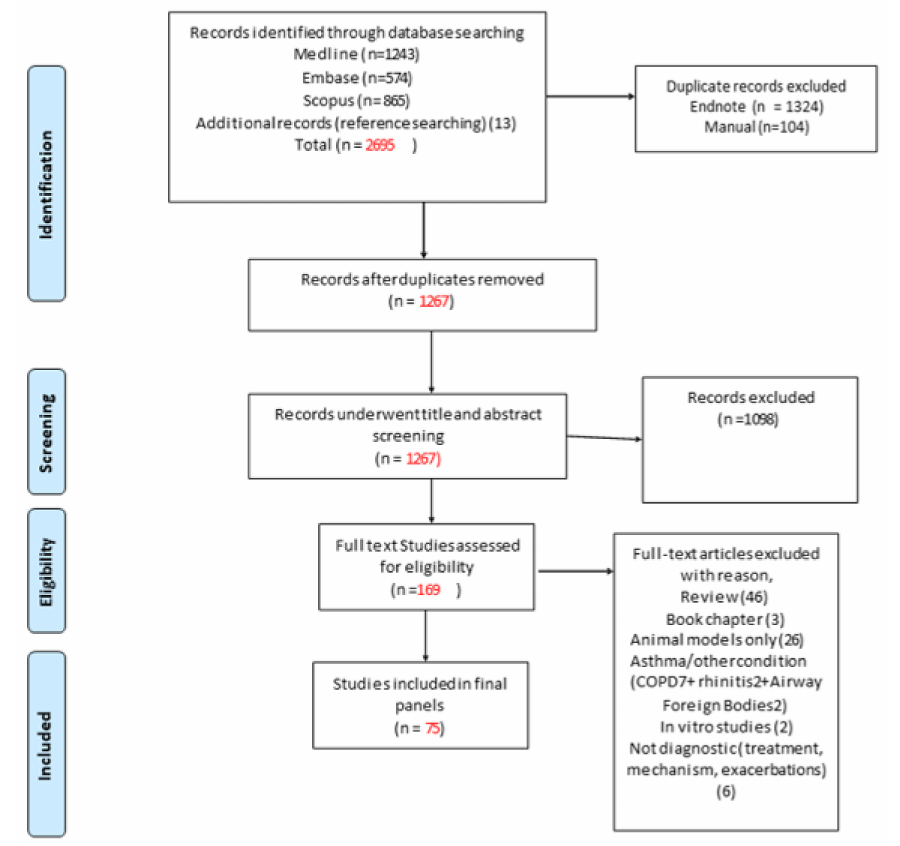
Figure 1. PRISMA flow diagram detailing search results [18].